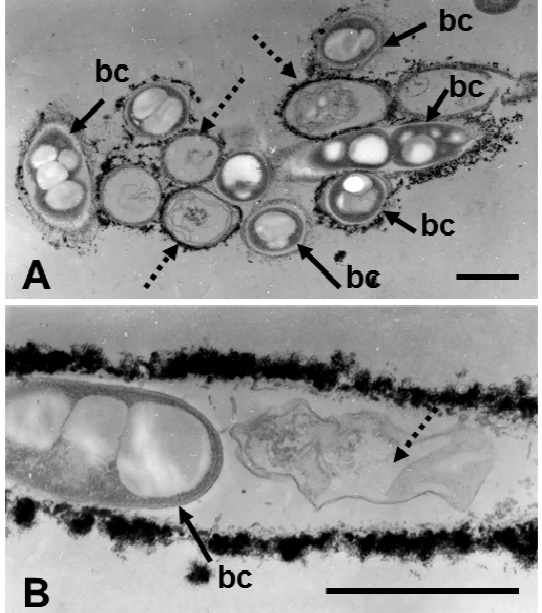
Figure 4. Transmission electron micrographs of cross ( A ) and longitudinal sections ( B ) of sheaths harvested on day 3 of culture in SGPI broth. ( A ) Some sheaths enclosed fully shaped cells (bc), but others contained deformed cells or their remnants (dotted arrows). And ( B ) thick, electron-dense sheath walls enclose a fully shaped cell and cell remnants (dotted arrow) side by side. Scale bar = 1 μ